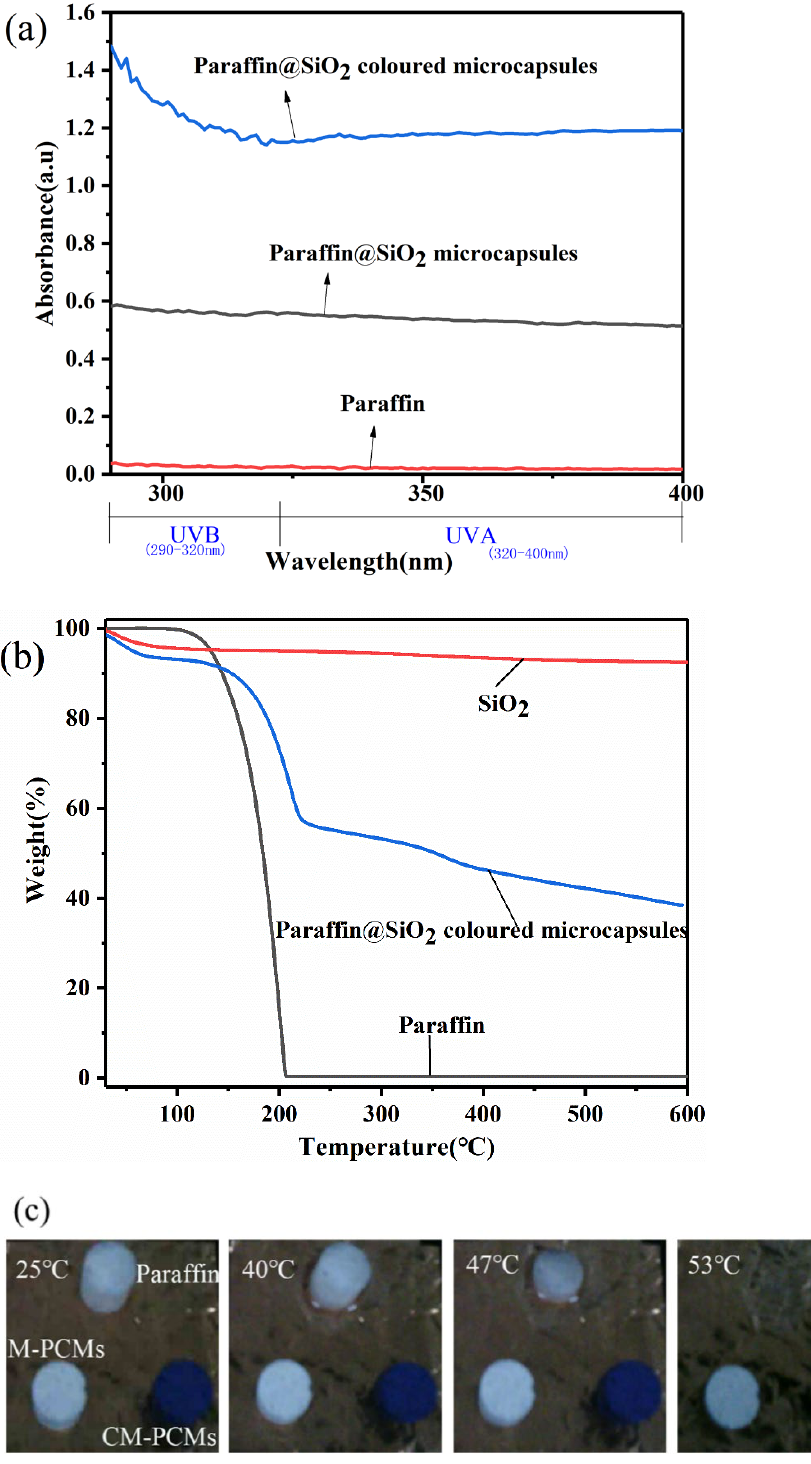
Figure 11. ( a ) UV–vis spectra of pristine paraffin, paraffin@SiO 2 microcapsules, the paraffin@SiO 2 col- ored microcapsules with same mass fraction; ( b ) TGA analysis of pristine paraffin, the paraffin@SiO 2 colored microcapsules, and SiO 2 nanoparticles; and ( c ) pictures before and after the leak test of the paraffin, paraffin@SiO 2